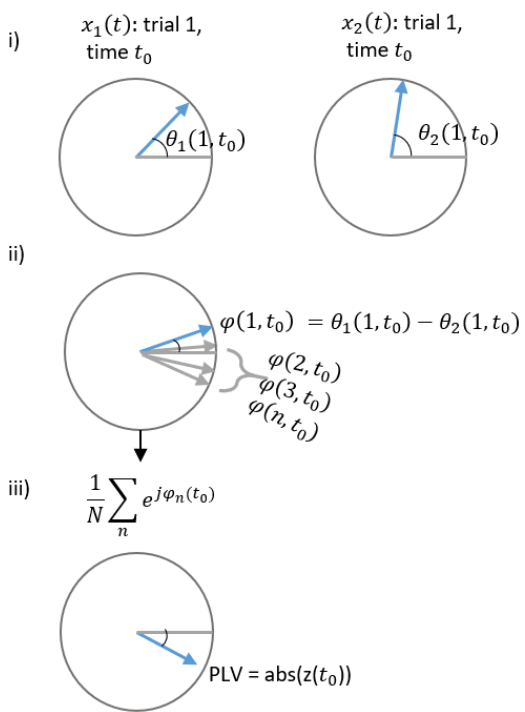
Figure 2. Correlated signals and corresponding PLV. (i) phases of a single trial of two complex-value signals at t o , (ii) difference between phases for multiple trials is presented (iii) The resulting in complex PLV for the correlated signals.